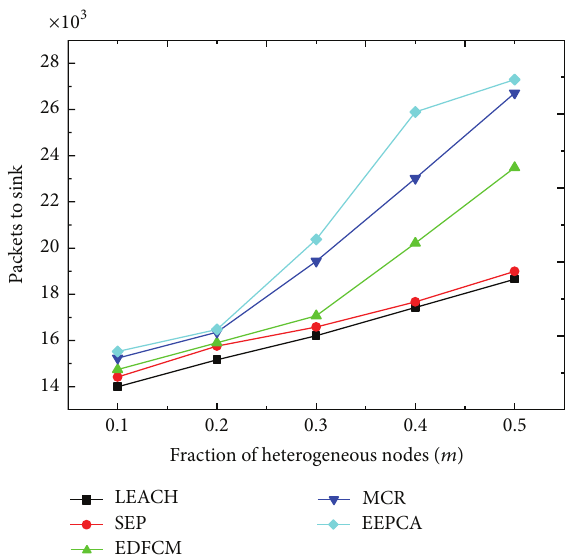
Figure 10: Round of first node dies with varying fraction of heterogeneous nodes. Figure 11: Packets to sink with varying fraction of heterogeneous nodes.